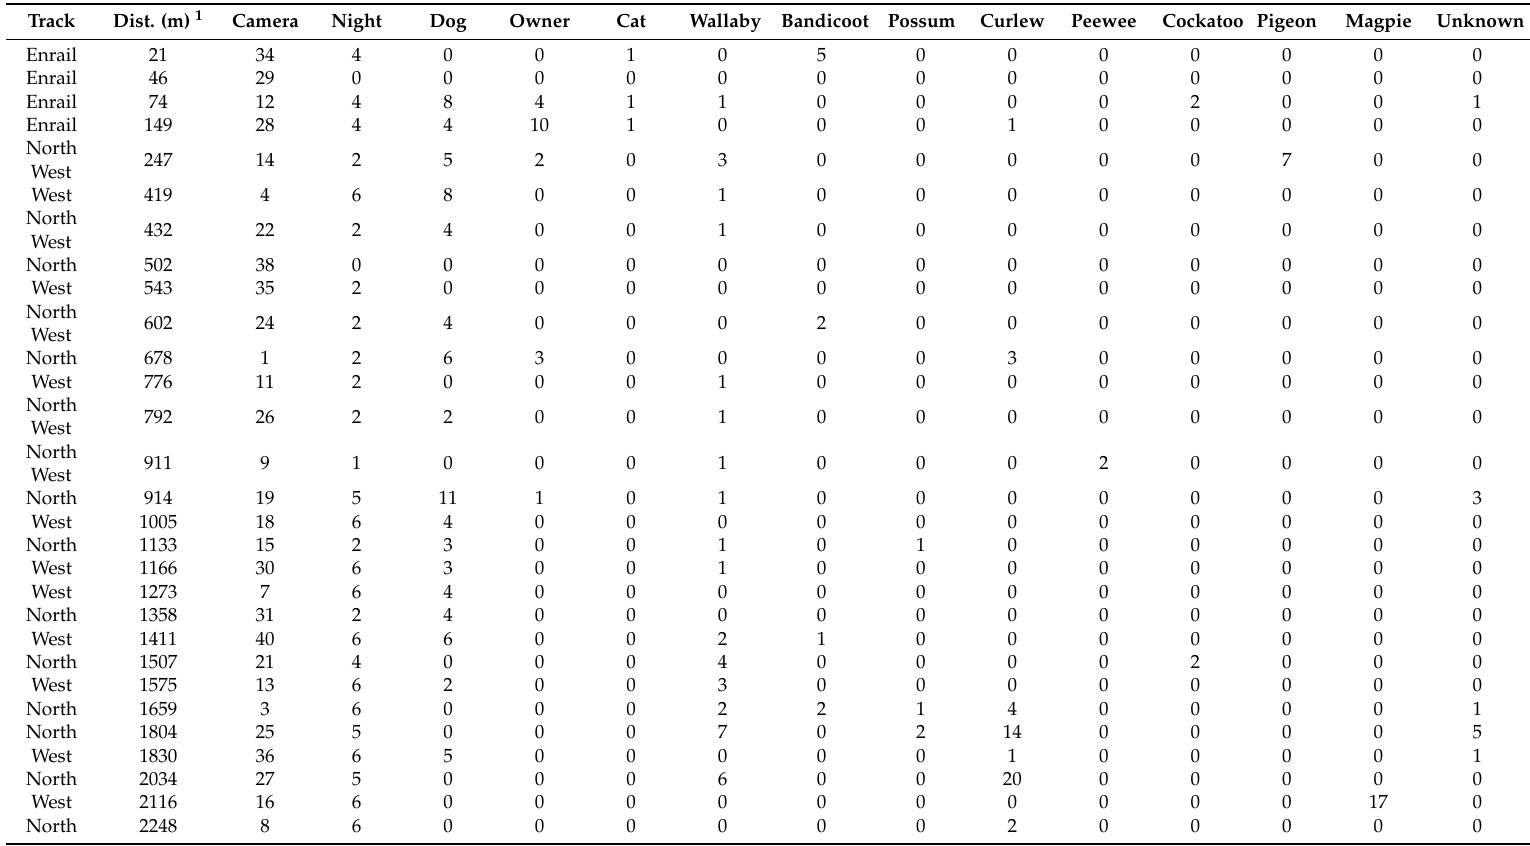
1 Distance (in metres) between the camera and the nearest